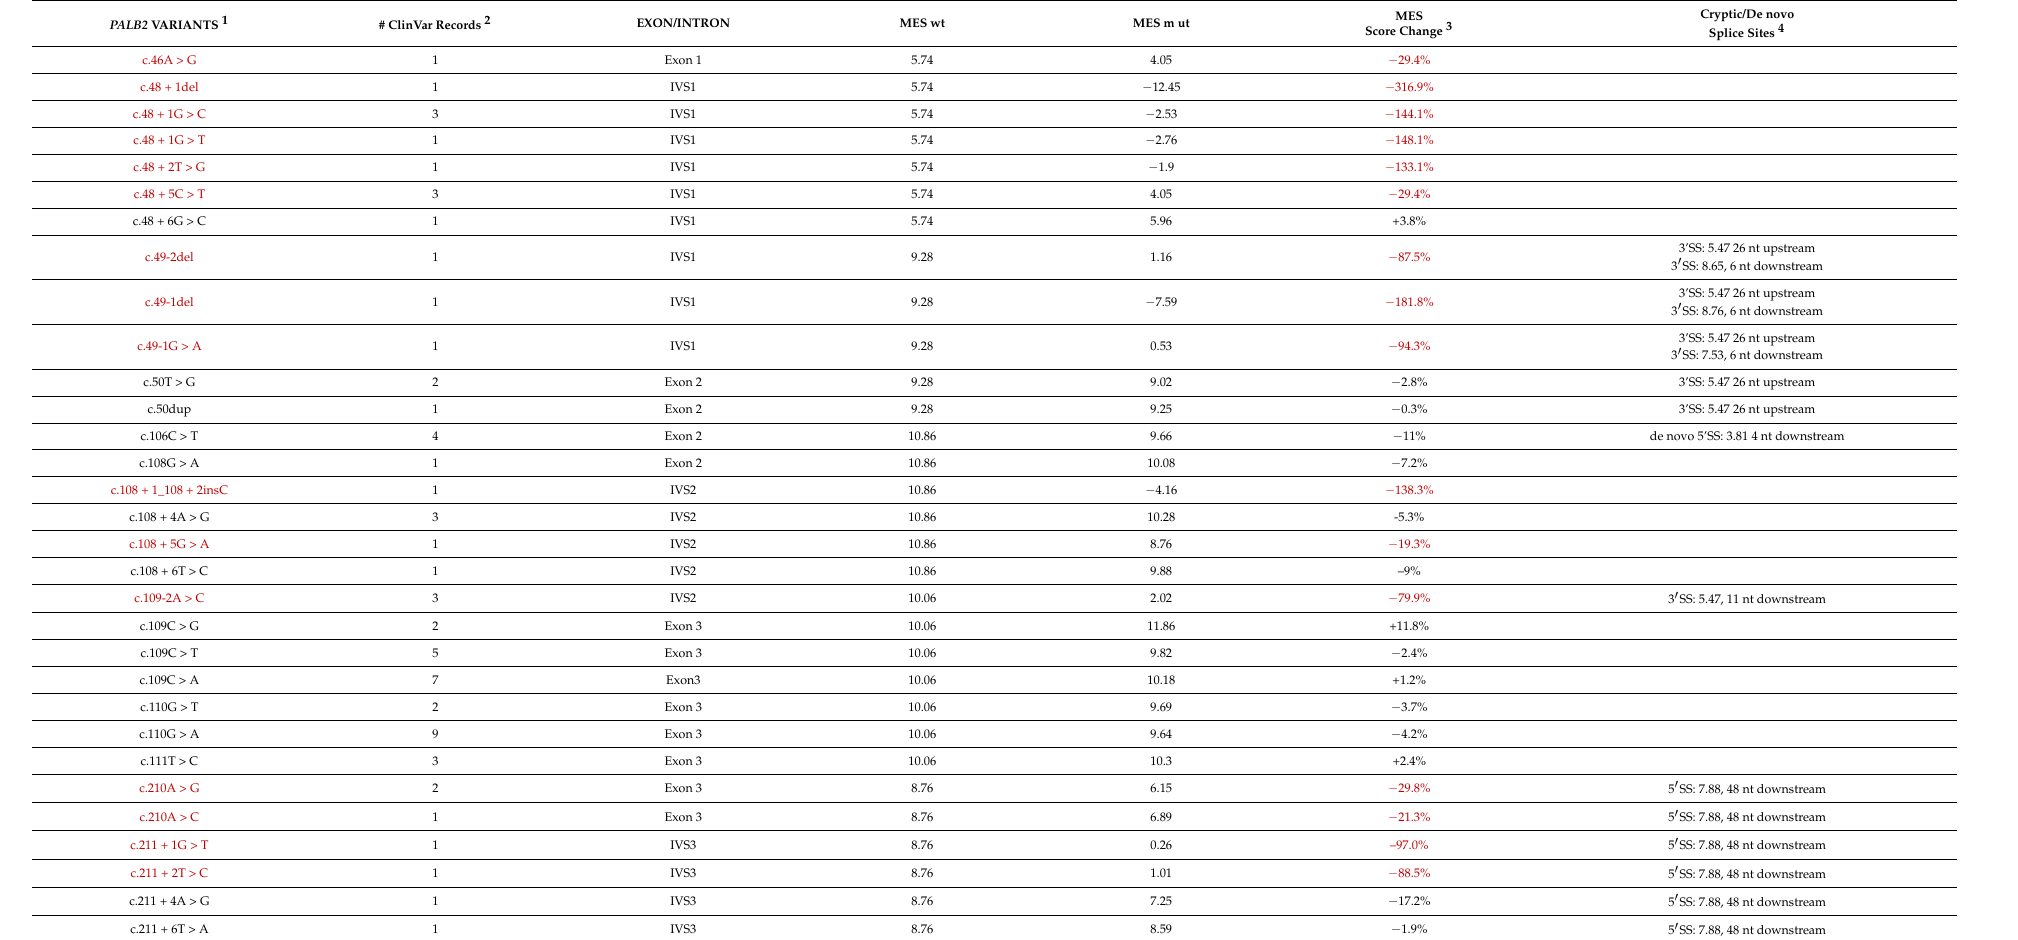
Table 2. Bioinformatics analysis of PALB2 variants with Max Ent